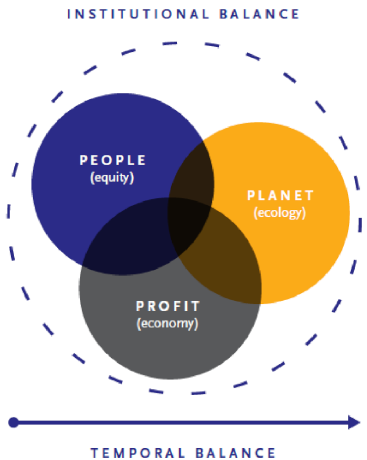
Figure 1. Understanding sustainability (source: [25] (p.